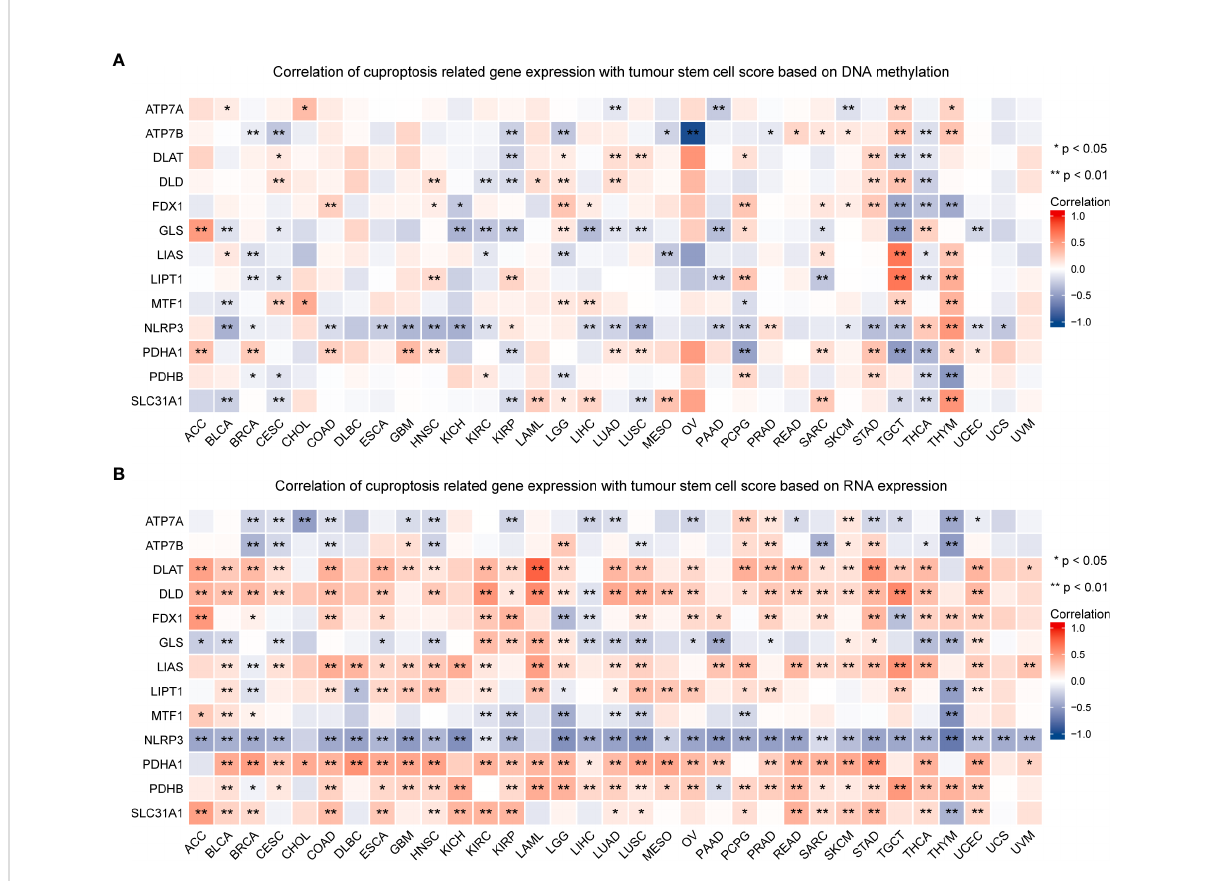
FIGURE 11 Association of the expression of cuproptosis-related genes with tumor stemness in pan-cancer. The correlation between the expression of cuproptosis-related genes and tumor stemness scores based on DNA methylation (A) and RNA expression (B) (*P < 0.05; **P <